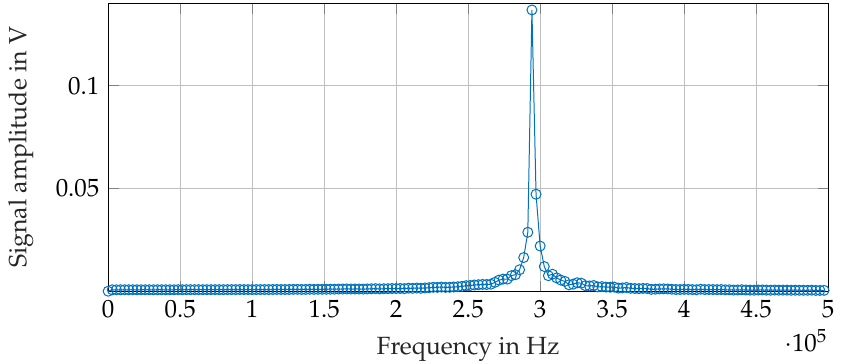
Figure 16. Receiver signal: Fast Fourier Transformation of the marked region in Figure 14.